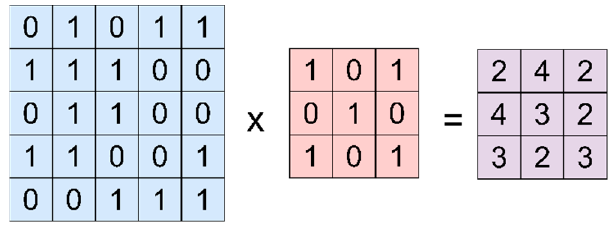
Figure 6. Convolution calculation.